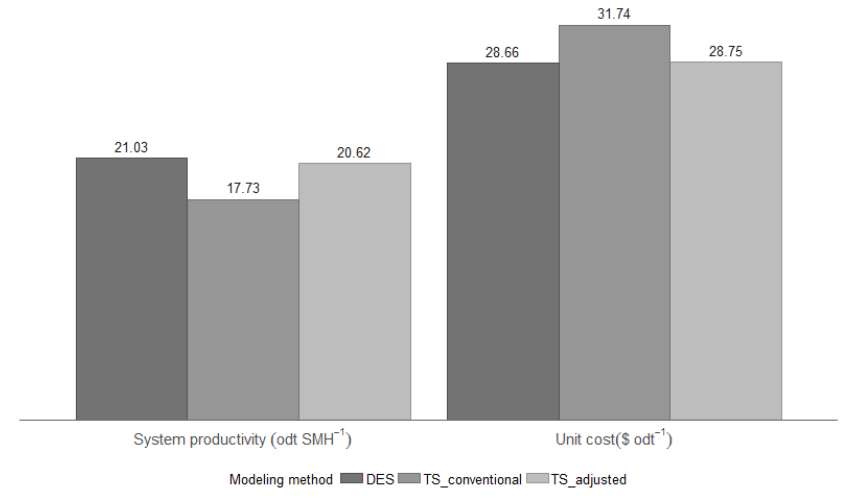
Figure 10. LS system performance estimated by the DES, TS conventional and TS adjusted models.